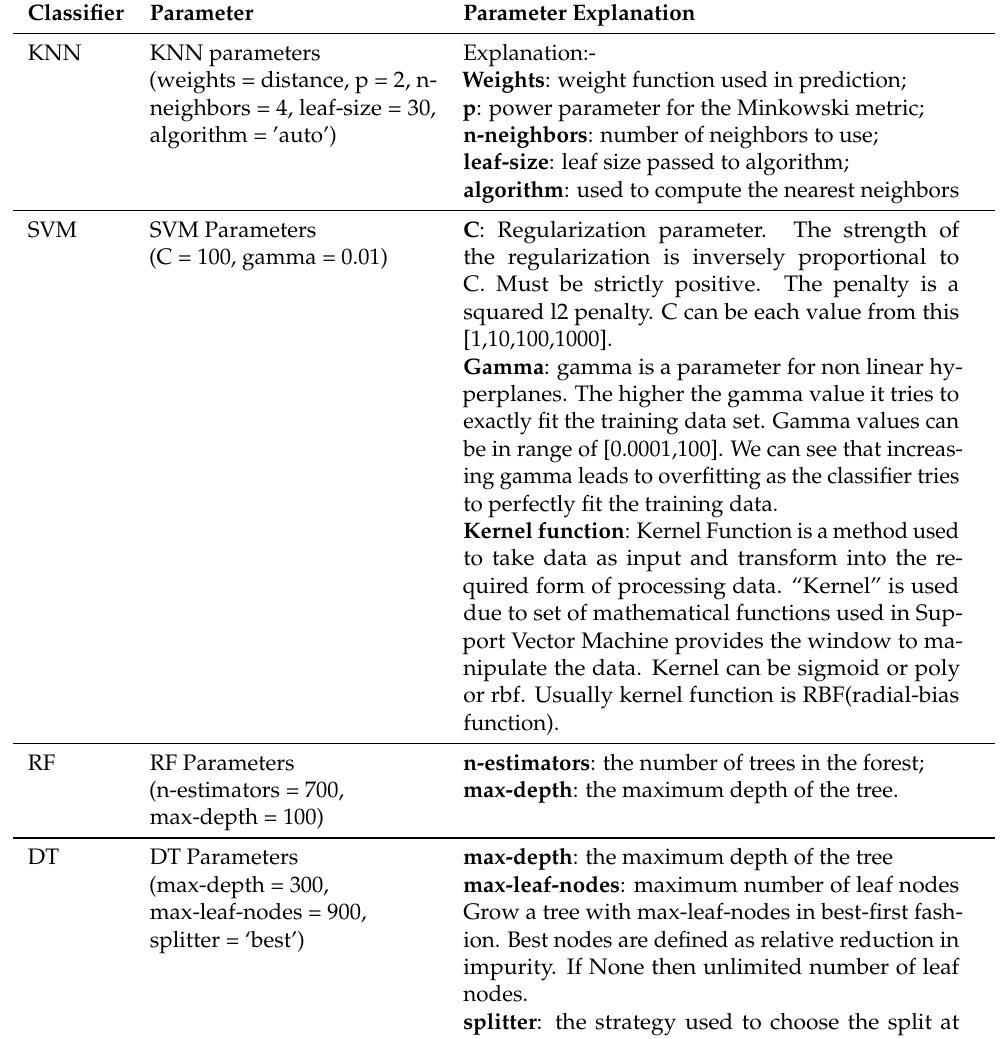
Table 11. Parameters of Classifiers Definition used in the Stacking Model after applying Hyper- parameter